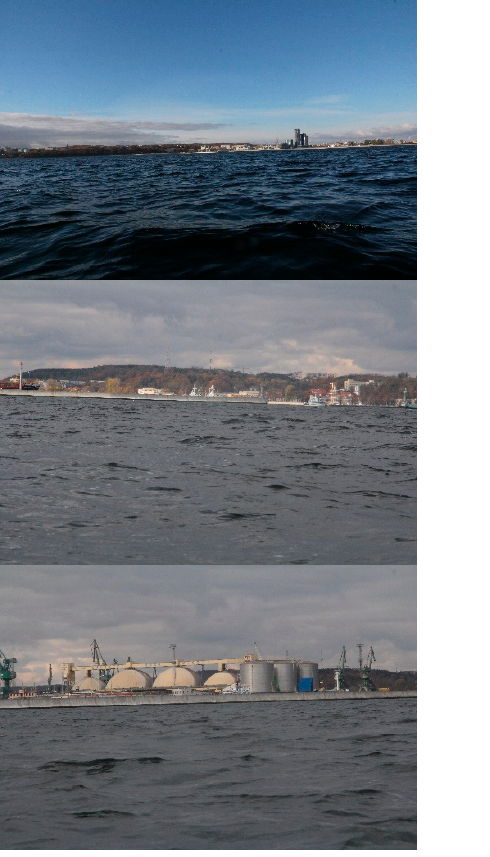
Figure 18. Results of the Grabcut algorithm.